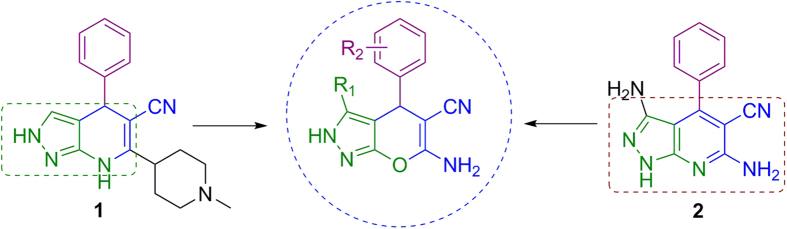
Selection of 2,4-dihydropyrano[2,3-c]pyrazole compounds based on structural features observed in known GSK3β inhibitors (1 and 2).